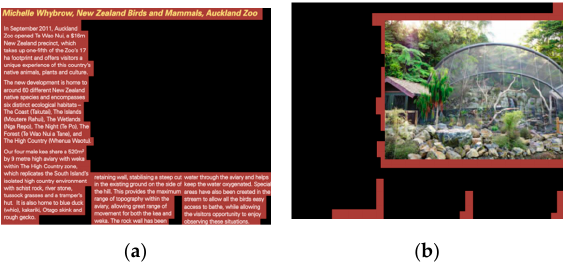
Figure 3. An example of the segmentation method of an SCI; ( a ) and ( b ) are textual and pictorial regions of ( b ) from Figure 1, respectively.